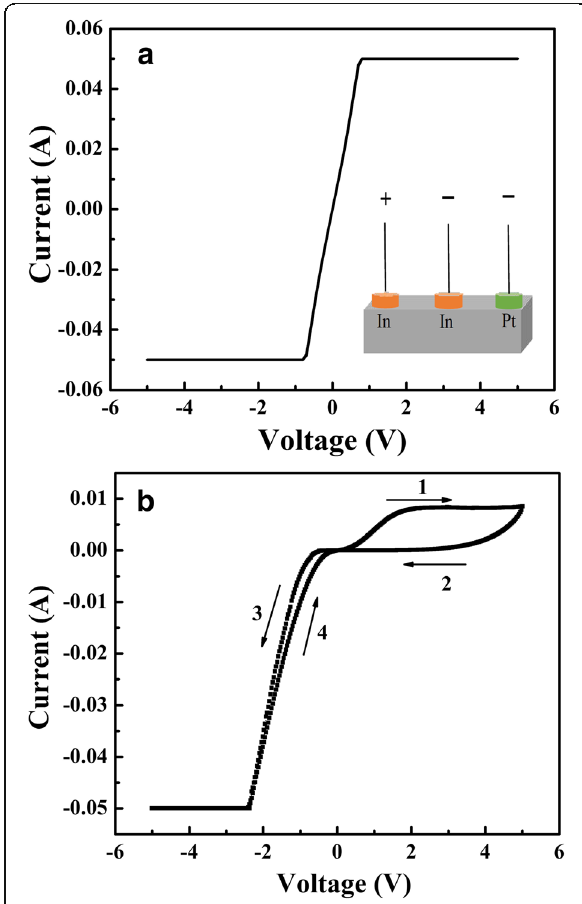
Fig. 2 The I – V characteristics of a the In/Nd:STO/In and b Pt/Nd:STO/In devices in the voltage range from 0 V → 5 V → 0 V → − 5 V → 0 V with 50-mA compliance current. The inset shows the device schematic